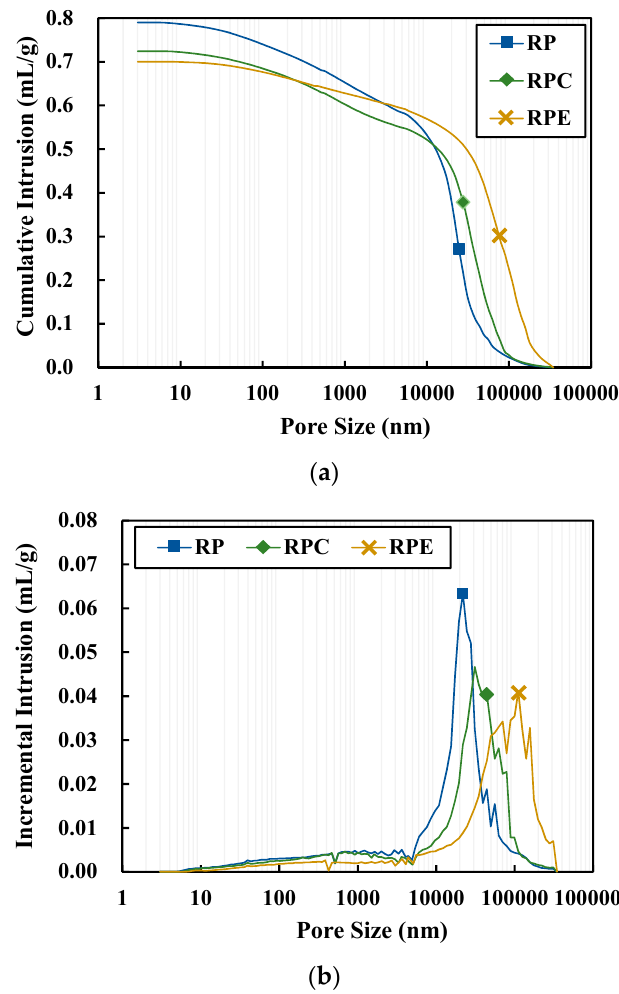
Figure 7. MIP results for the red clay binder specimens at 24 h. ( a ) Cumulative intrusion and ( b ) incremental intrusion.